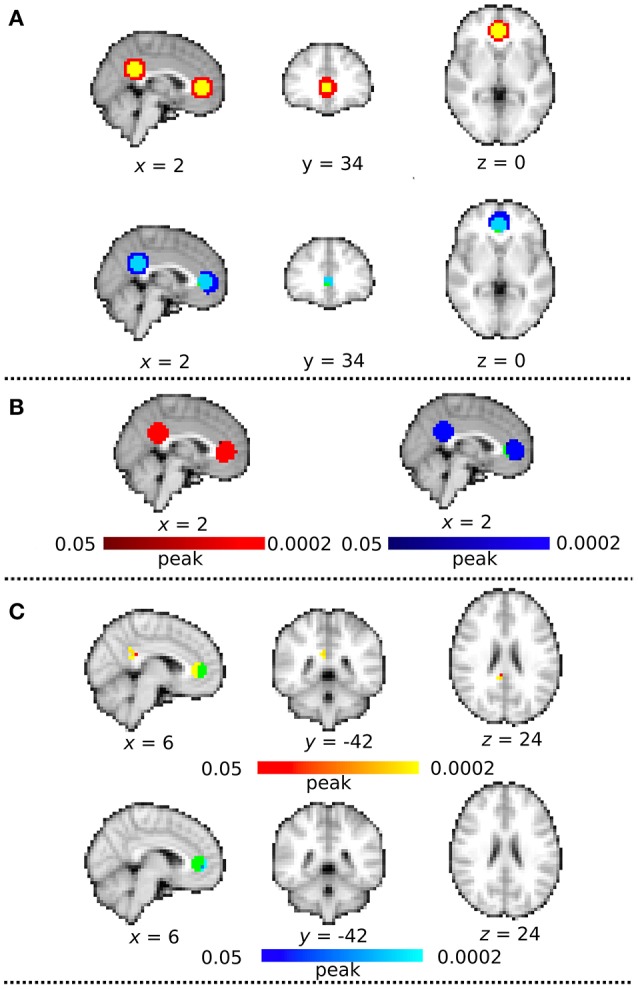
Synthetic MRI analysis. (A) The spatial correspondence between the masks and each group independent components analysis (ICA) map with distortion correction (DC+) and without DC (DC−). All clusters are binarized. Green color indicates the sphere mask image of 10-mm radius centered at the MNI coordinate of x = 2, y = 42, z = 4 (corresponding to ACC) and x = 2, y = −46, z = 28 (corresponding to PCC). Red indicates DC+ group ICA map and Blue indicates DC − group ICA map. Yellow indicates the region overwrapped between the masks and DC+ group ICA map, and lightblue indicates the region overwrapped between the masks and DC− group ICA map. (B) Group mean map in dataset with distortion correction (DC) (Red) and without DC (Blue). Green color indicates the sphere mask image of ACC and PCC volumes-of-interest (VOIs) (multiple comparison family wise error correction across voxels and contrast; p < 0.05). (C) Functional connectivity on the synthetic DC+ and DC− dataset. These clusters are masked by the ACC and PCC mask image to be focused on the voxels overwrapped between the masks and the functional connectivity. Green color indicates the region of interest in ACC. Red-yellow color indicates clusters of significantly increased connectivity after field map correction in peak-based thresholds (multiple comparison familywise error correction across voxels and contrast; p < 0.05). Blue-lightblue color indicates clusters of significantly decreased connectivity with field map correction in peak-based thresholds.